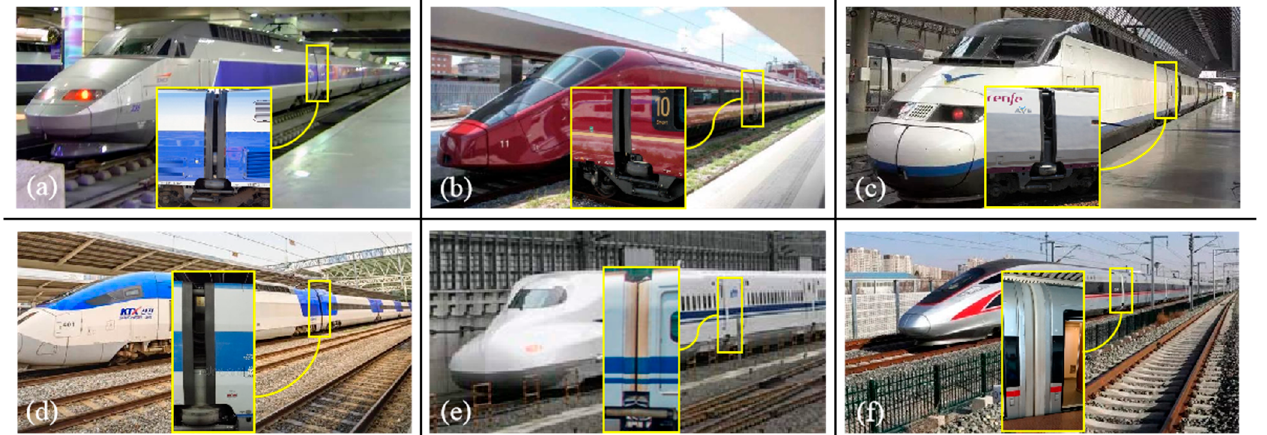
Figure 1. HSTs having various outer windshield configurations: ( a ) TGV in France, ( b ) AGV in Italy, ( c ) AVE in Spain, ( d ) KTX2 in Korea, ( e ) N700 in Japan, ( f ) CR400 in China.